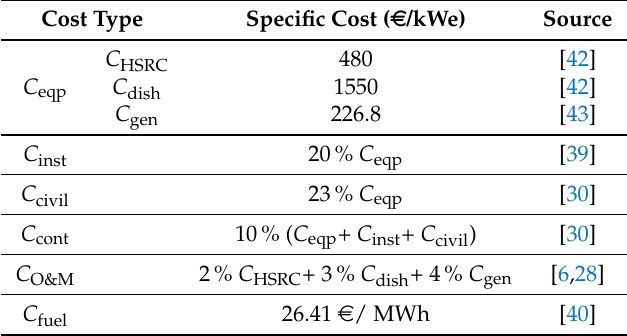
Table 2. Cost parameters used to estimate the Levelized Cost of Electricity (LCoE) and the corresponding sources. Total costs appearing in Equation (12) are obtained as the simple product of specific costs by the plant nominal power output, except for fuel costs that are already expressed in e /MWh.